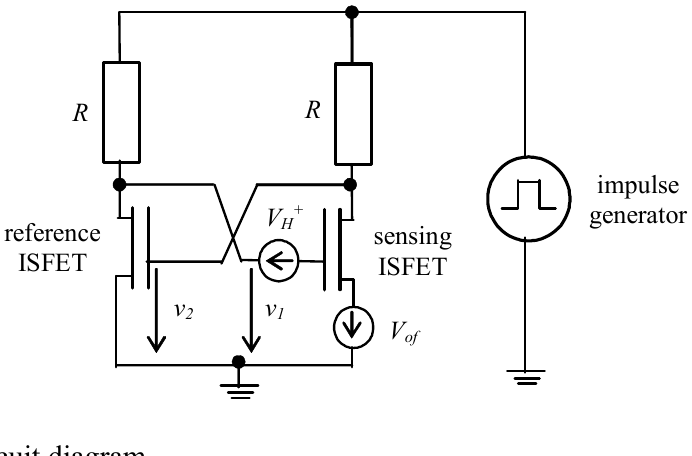
Figure 3. Equivalent circuit